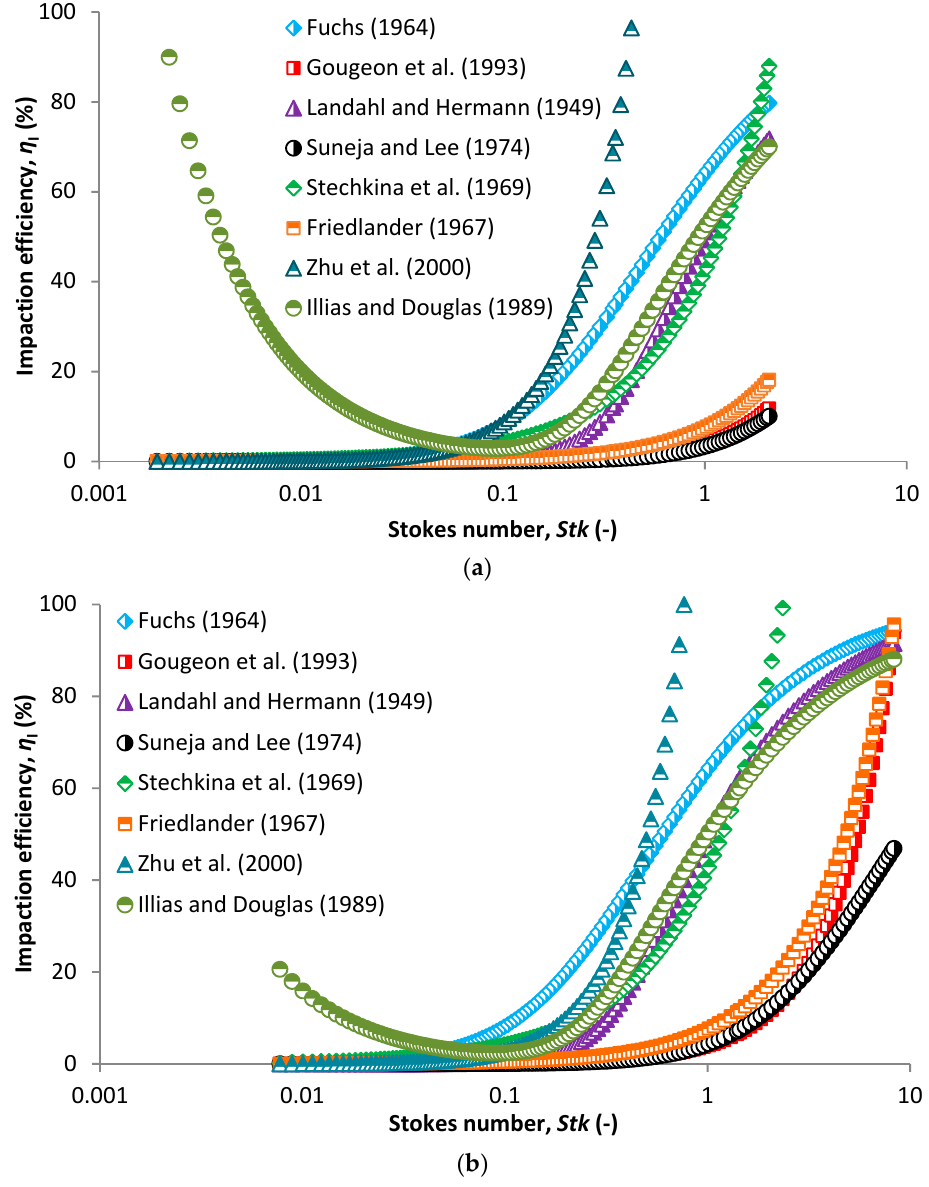
Figure 5. Comparison of impaction efficiency based on different models and airflow velocity of 5 cm/s ( a ) and 20 cm/s ( b ) in relation to Stokes number.